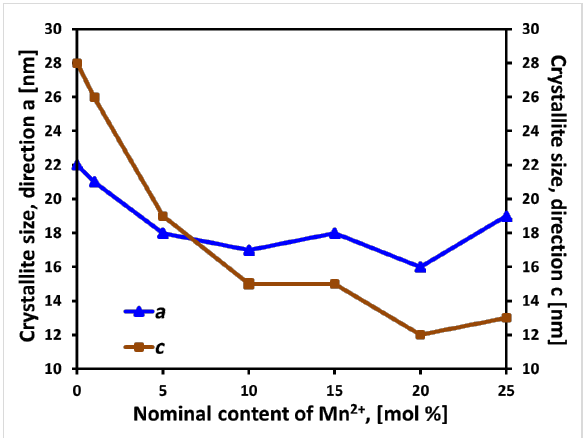
Figure 7: Dependence of the changes in crystallite size on the nomi- nal content of Mn 2+ -dopant in Zn 1 − x Mn x O.